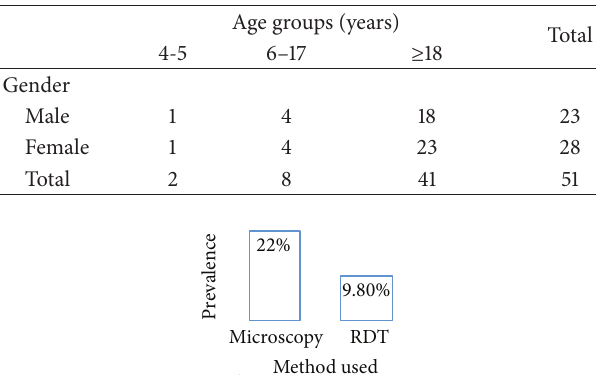
Table 1: Age distribution of people enrolled in the study.